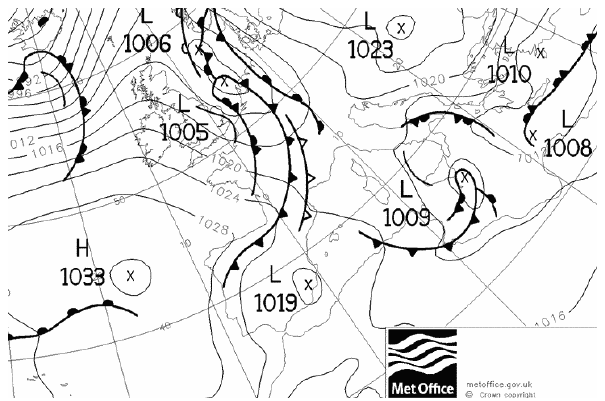
Figure 8. UK Met Office surface pressure chart for 26 February 2011 18:00UTC (cropped). Contains public sector information li- censed under the Open Government Licence